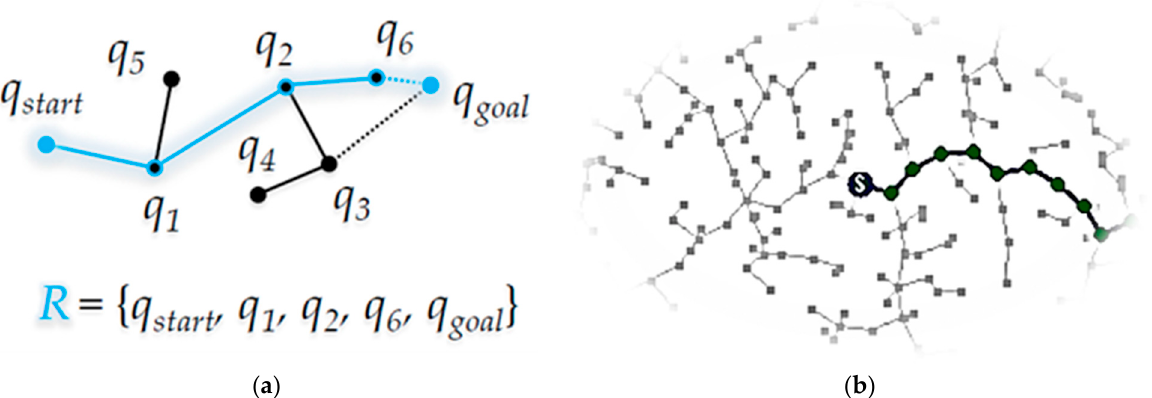
Figure 1. Overview of the rapidly-exploring random tree (RRT) algorithm: ( a ) planned path R from starting point q start through waypoints q 1 , q 2 , q 6 to destination q goal ( q i is a point on the path); ( b ) process of finding destination point by stochastic fractal shape from the root node (S) as a starting point.